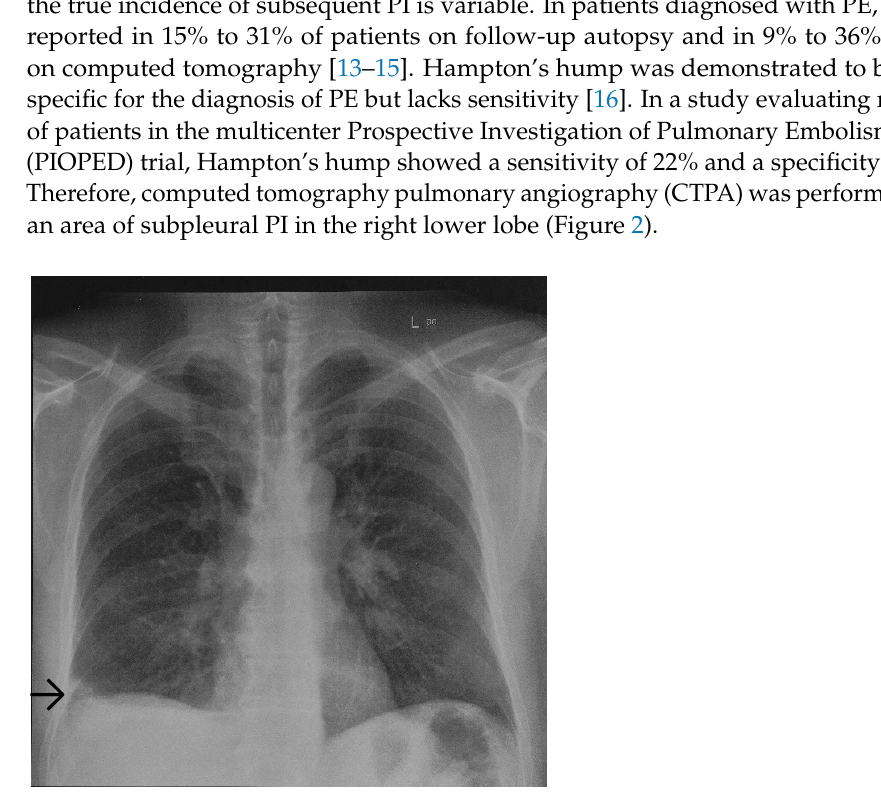
Figure 1. Posterior-anterior view of a chest radiograph demonstrating a basal wedge-shaped consoli- dation indicative of a Hampton’s hump (arrow) in the right lower